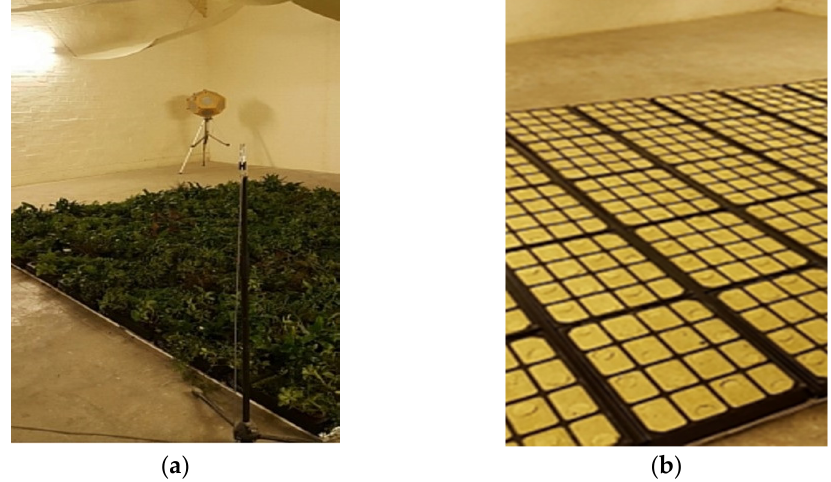
Figure 4. Biotecture green wall wall system: ( a ) Living wall system, with plants; ( b ) green wall system, without plants.